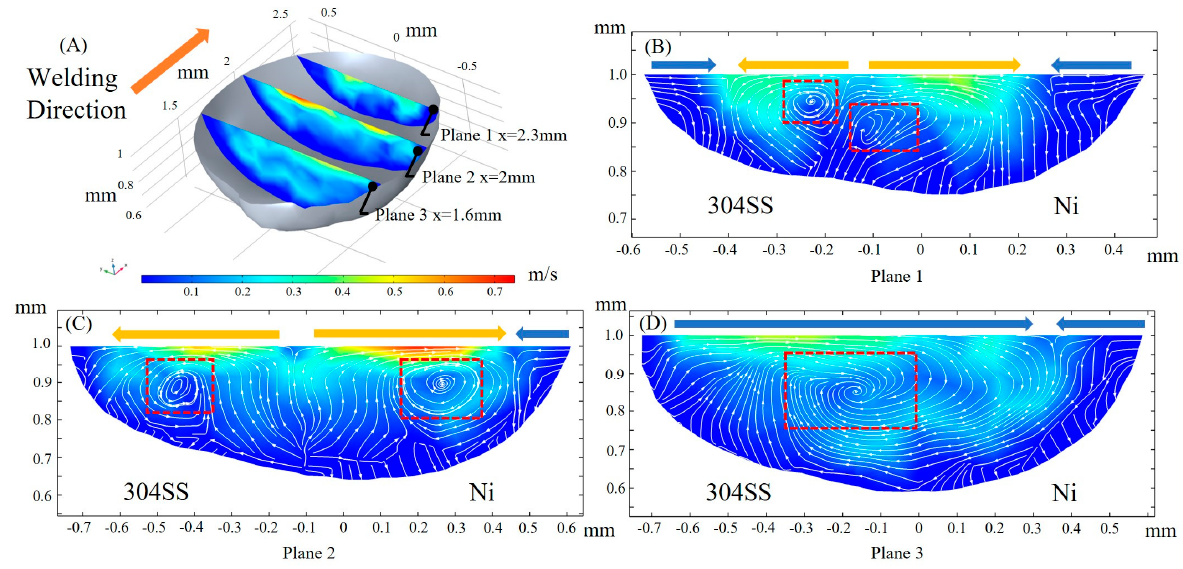
Figure 9. Fluid flow at the yz cross section. ( A ) 3D view; ( B ) x = 2.3 mm; ( C ) x = 2 mm; ( D ) x = 1.6 mm.